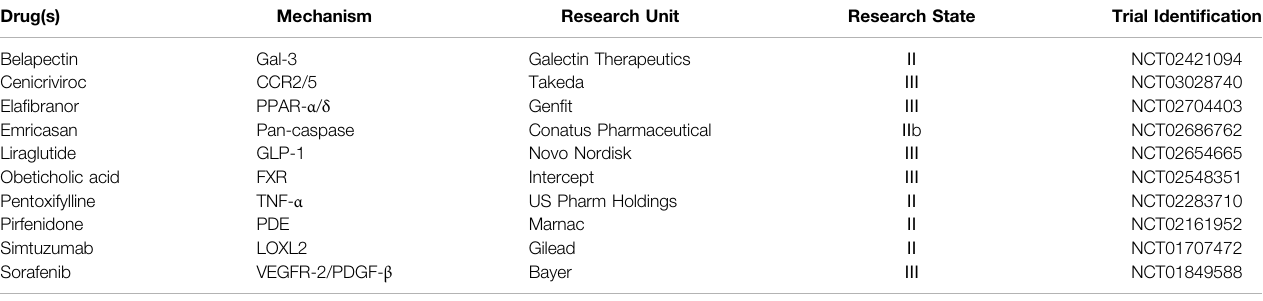
TABLE 1 | List of drugs currently being evaluated in phase Ⅱ and phase Ⅲ clinical trials.